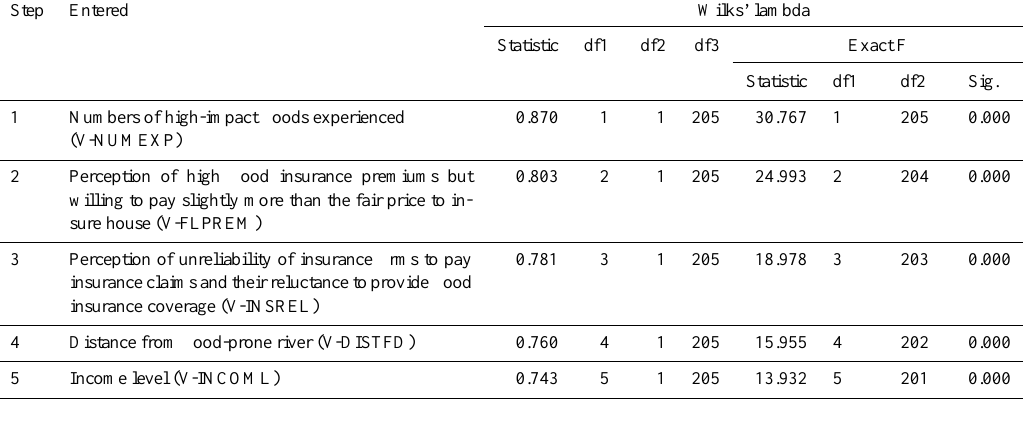
Table 2. Predictive model of flood insurance purchase. Variables entered/removed a , b , c , d